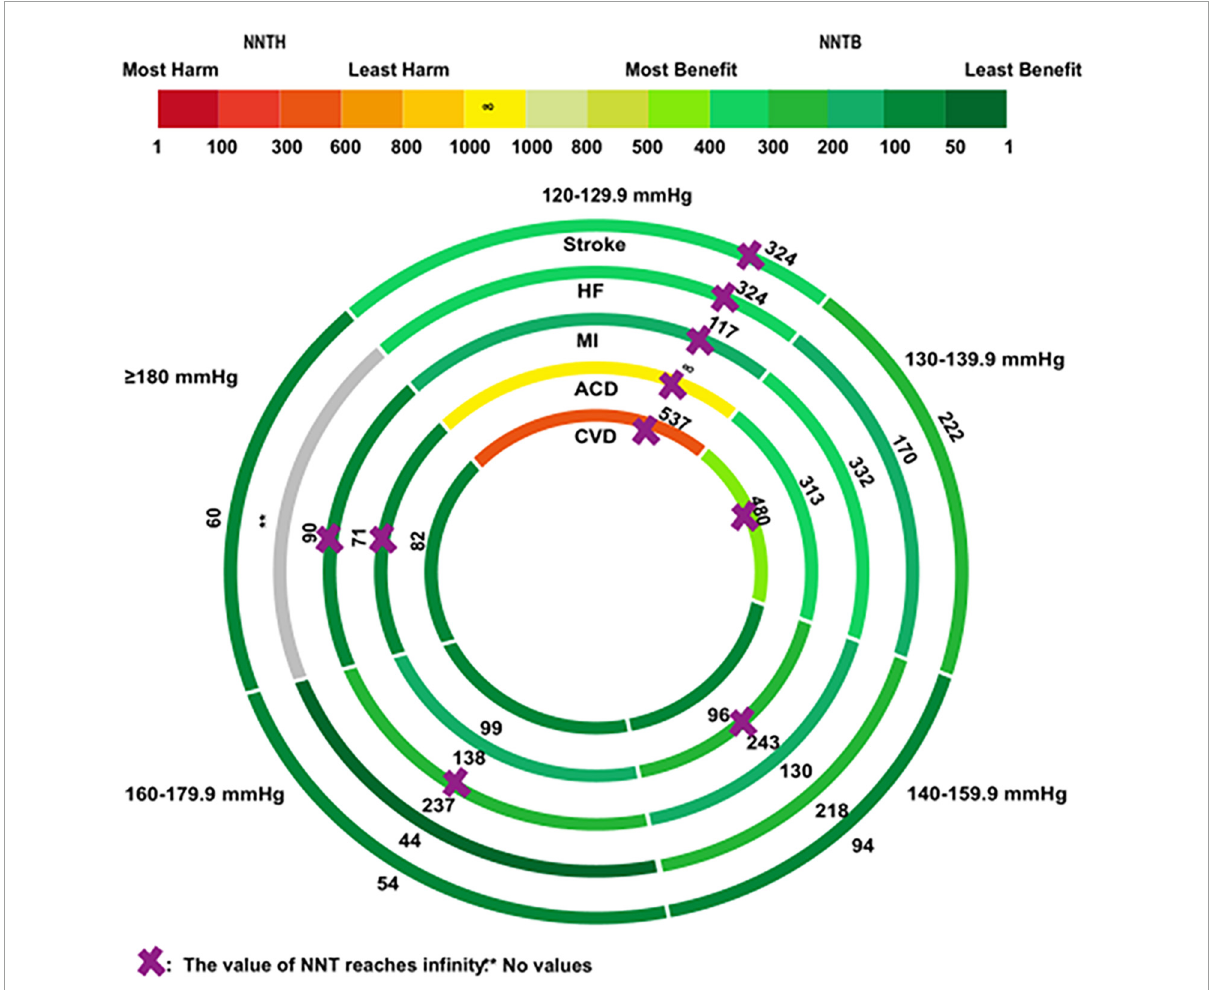
FIGURE3 The rank-heat plot of the NNT values for secondary outcomes across five baseline SBP levels. Circles from outside in refer to first, stroke; second, heart failure (HF); third, myocardial infarction (MI); fourth, all-cause death (ACD); fifth, cardiovascular death (CVD). Sectors with a “purple cross” mean that the values of NNT reach infinity. The sector with a “two asterisks” means that there is no values in the group. Each section is colored according to the NNT value of the corresponding SBP and outcome. The scale consists of the transformation of three colors red (NNTH = 1), yellow (NNTB/NNTH = ∞ ), and green (NNTB = 1). The redder the color of the section, the smaller the NNTH is; the greener the color of the section, the smaller the NNTB is. Each section also includes the NNT value corresponding to the specific baseline SBP and outcome. Mean follow-up duration is 3.50